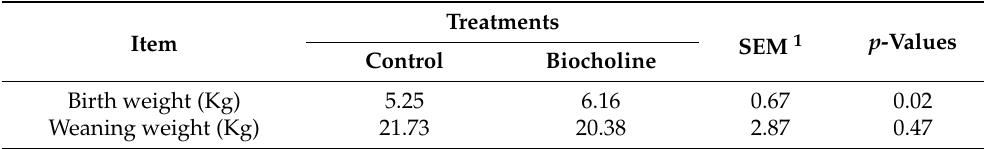
Table 4. Productive performance of lambs born from Rambouillet ewes supplemented with an herbal mix as a source of choline during early gestation.